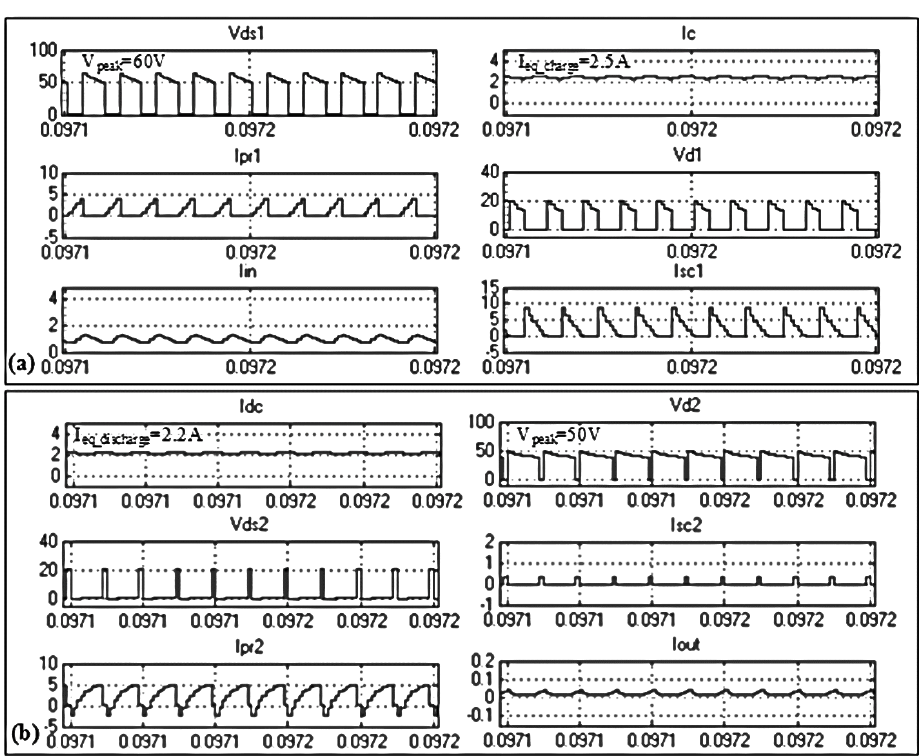
Figure 9. Flyback DC–DC converter outputs during ( a ) charging and ( b ) discharging.